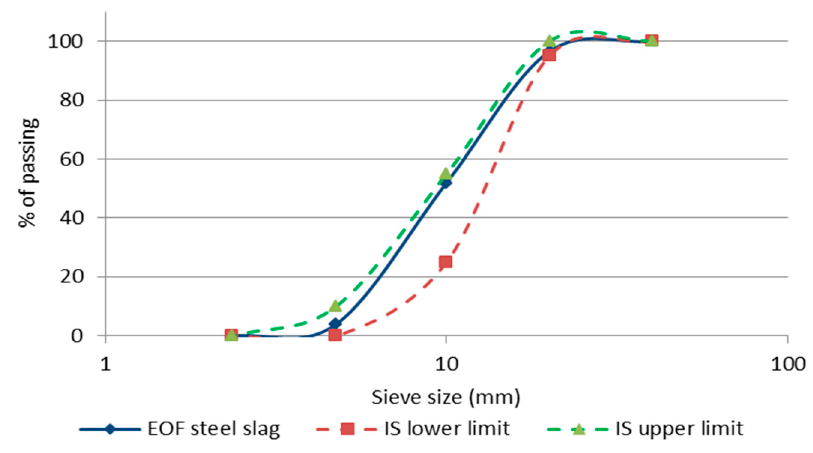
Figure 3. Granulometric curve. Table 2. Shape properties of natural coarse aggregate and EOF steel slag.